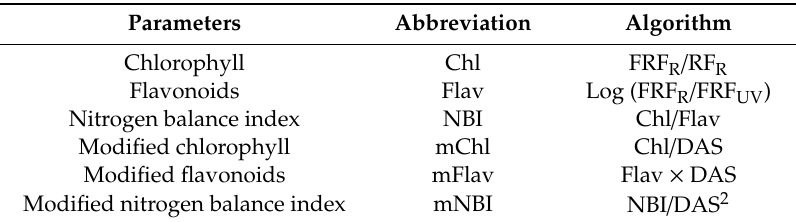
Table 2. The details of Dualex 4-based